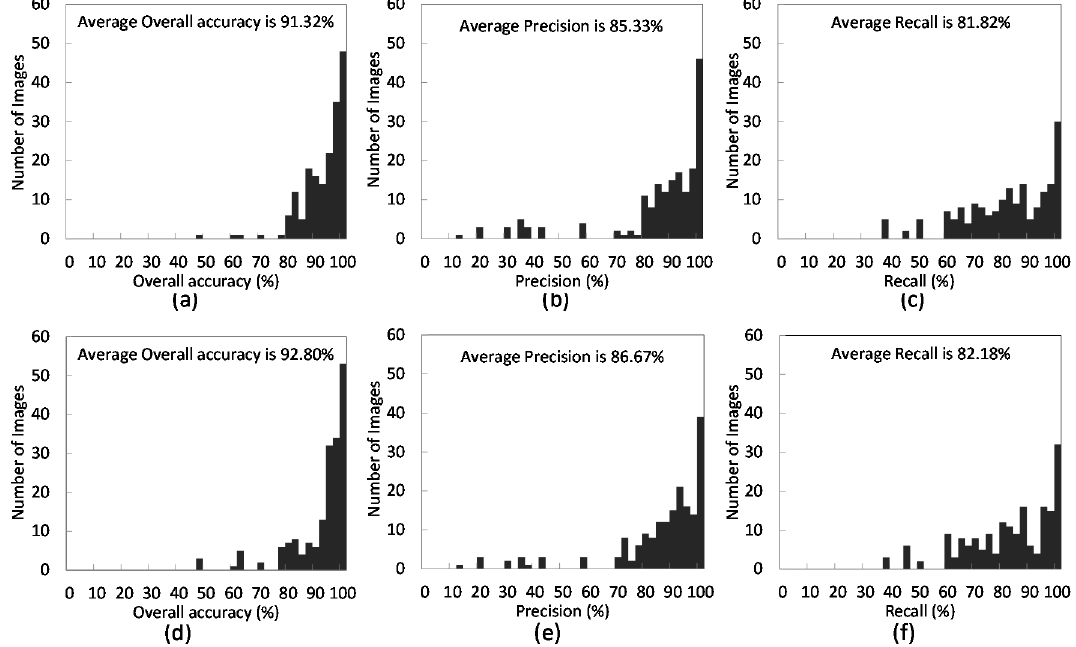
Figure 12. Histogram of the cloud overall accuracy, precision and recall: ( a – c ) accuracy, precision and recall for clouds, respectively; and ( d – f ) for snow.